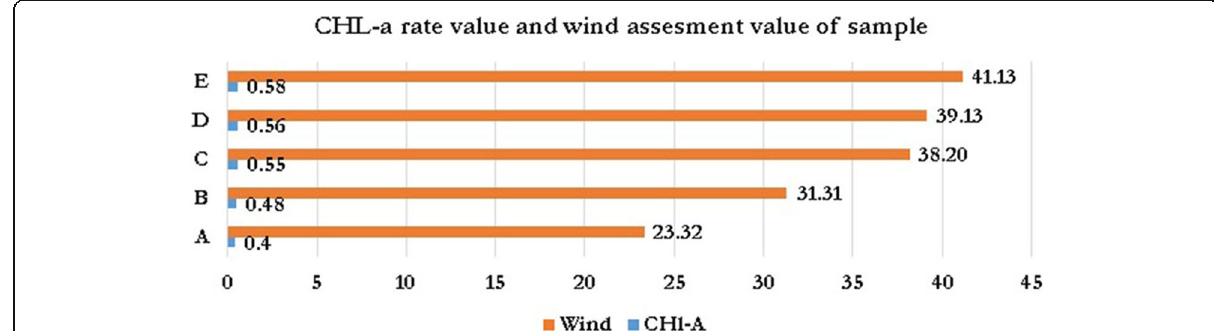
Fig. 15 The distribution in the normal